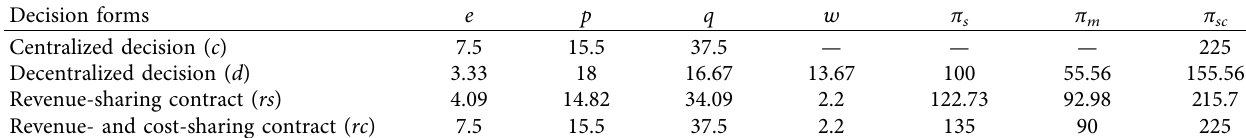
Table 3: Supply chain optimal decision and profit analysis under different decision models.